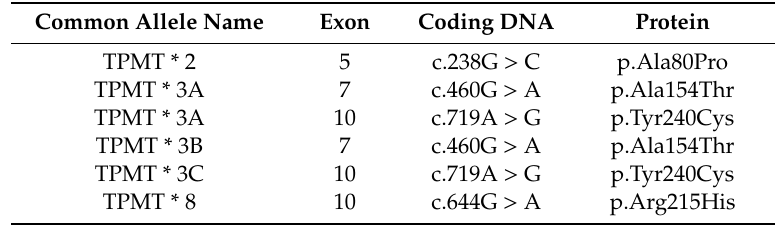
Table 1. Nomenclature of the most frequent non-functional alleles of the TPMT gene.